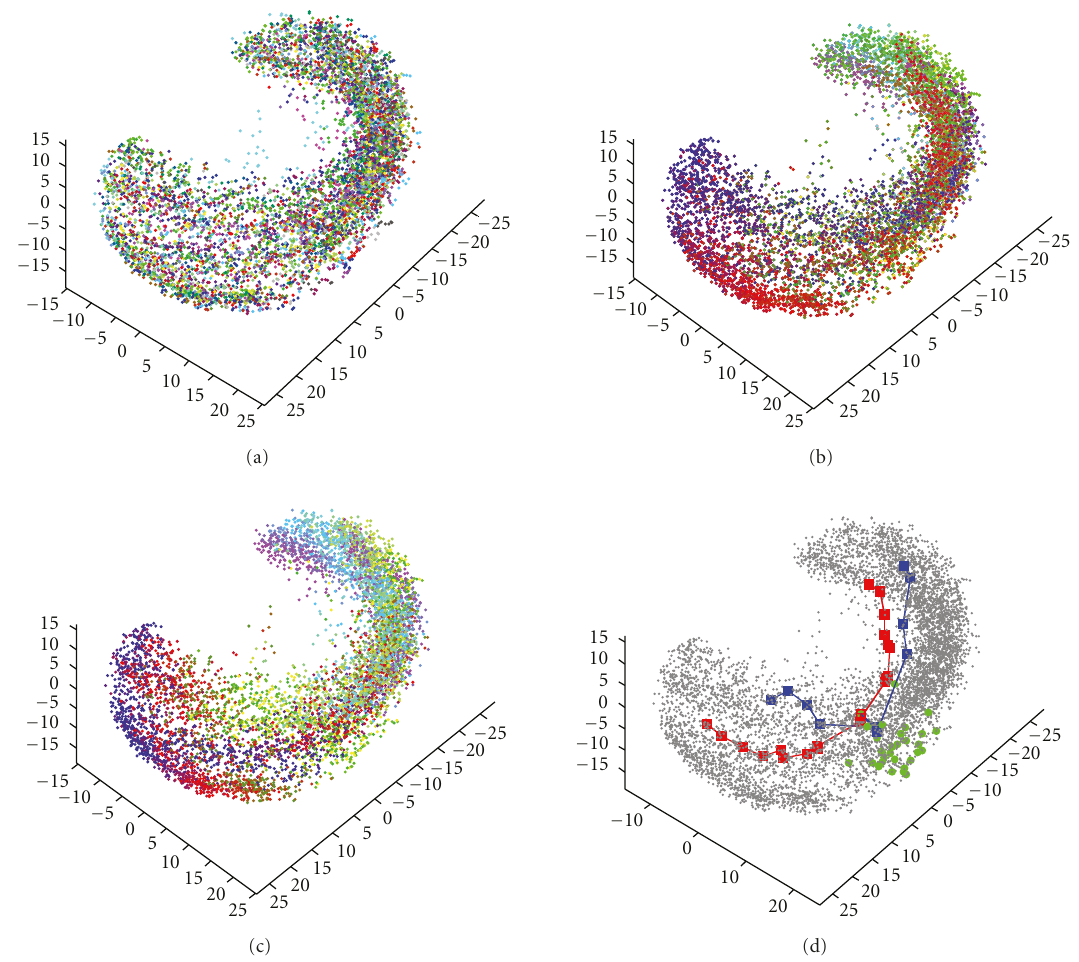
Figure 1: Low-dimensional representations of training images obtained by PCA using the CMU PIE database. (a) Each set of samples with the same color represents each subject’s face images. (b) Each set of samples with the same color represents face images under each viewpoint. (c) Each set of samples with the same color represents face images under each lighting condition. (d) The red C-shape curve connects face images under various lighting conditions for one person and one viewpoint. The blue V-shape curve connects face images under various viewpoints for one person and one lighting condition. Green dots represent 30 subjects’ face images under one viewpoint and one lighting condition. We can see that varying viewpoints and lighting conditions create clusters, rather than varying